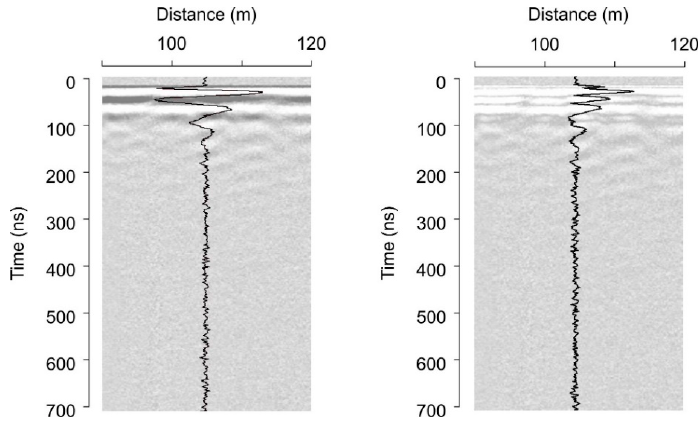
Figure 5. The first radargram presents A-scan and B-scan. The second radargram shows the absolute values of the A-scan and B-scan.